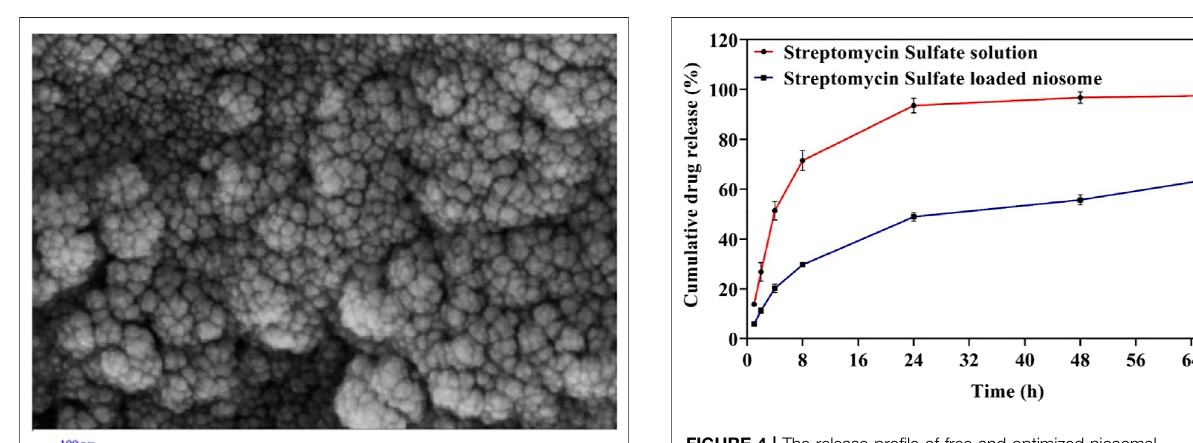
FIGURE 4 | The release pro fi le of free and optimized niosomal formulation of streptomycin sulfate. Each point represents the mean ± SD ( n (cid:1)